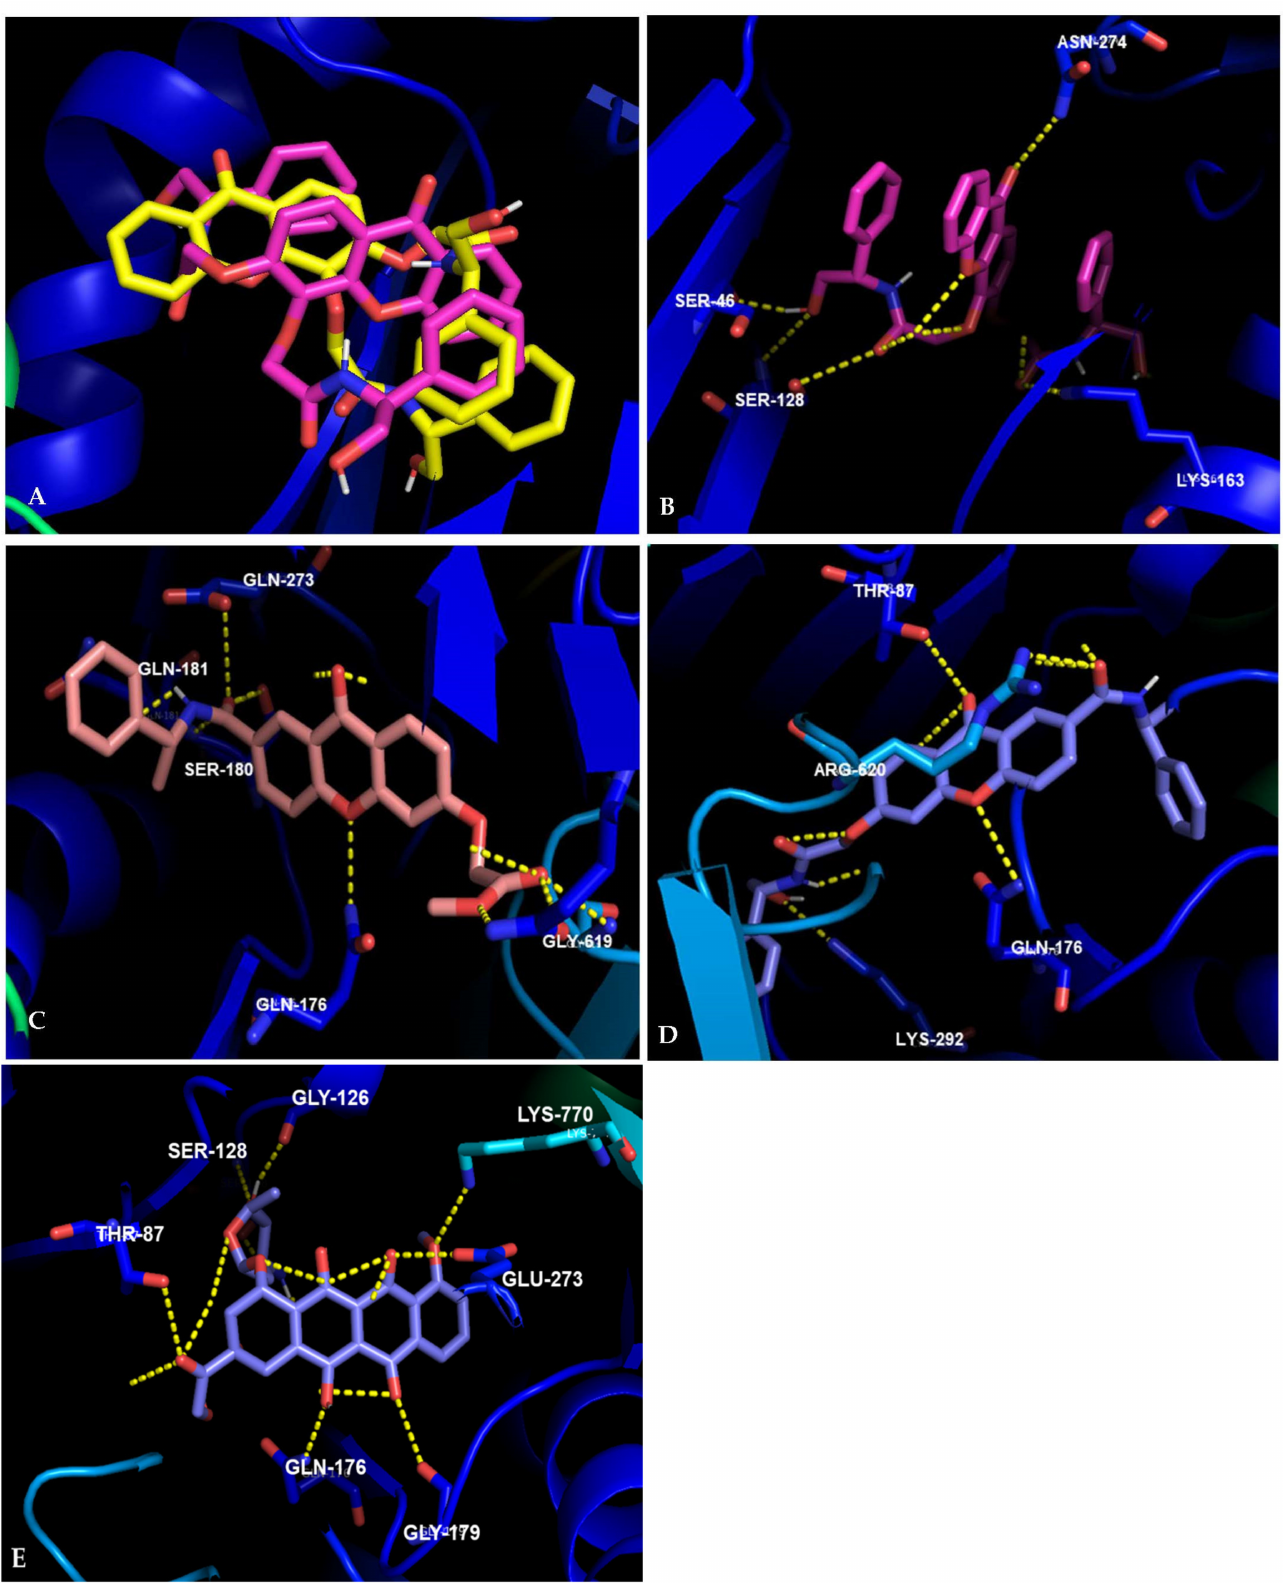
Figure 4. Molecular visualization of the effective compounds in the SBS of AcrB. ( A ) ( R , R )-8 (yellow) and ( S , S )-8 (pink) in the SBS of AcrB; ( B ) interactions of ( S , S )-8 with key residues; ( C ) interactions of ( R )-17 with key residues; ( D ) interactions of ( R , S )-18 with key residues; ( E ) interactions of doxorubicin with key